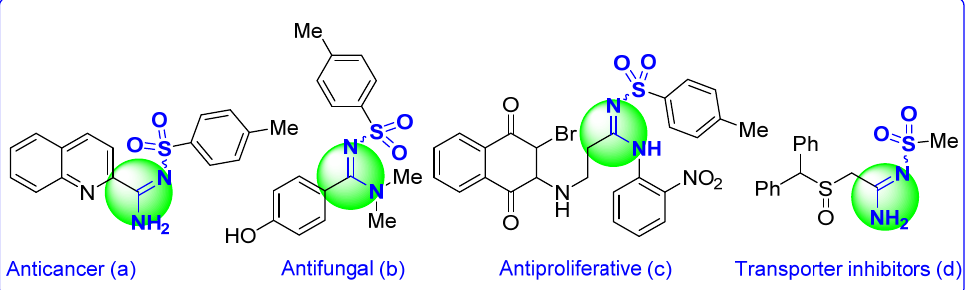
Figure 2. Examples of sulfonyl amidine drug candidates.